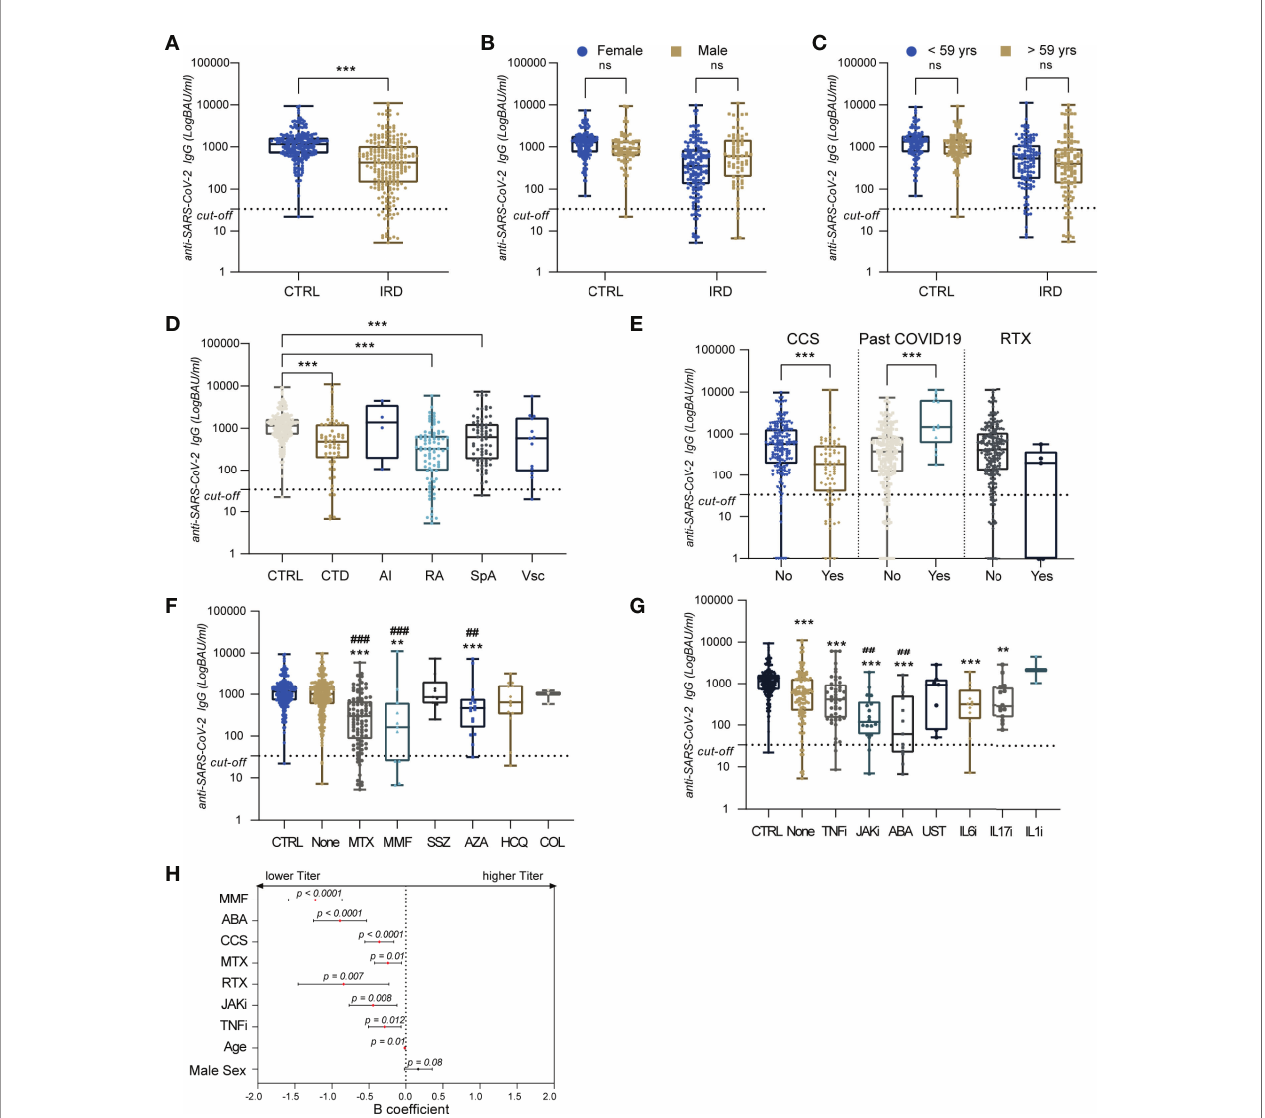
FIGURE 2 | Antibody titers after BNT162B2 vaccine in IRD and controls:Box and whiskers plot with individual data point anti-Sars-CoV-2 antibody tier expressed in BAU/mL, the box represents the IQR, line the median and hinges extend from the minimum to maximum value (A – G) . In (A) comparison of titer between control (CTRL) and patients (IRD). In (B, C) titer after strati fi cation for sex and age (> vs < the median), respectively. Levels of anti-Sars-Cov2 antibodies in the different patient ’ s groups are reported in (D) . In (E) antibody levels after strati fi cation for CCS use, past COVID19 and Rituximab treatment in the last 12 months. Antibody levels are compared across different csDMARDs (F) and bDMARDs/tsDMARDs (G) use. In (H) forest plot showing factors associated with seroconversion identi fi ed by linear stepwise regression displayed as 95% CI of B and p-value. *: statistically signi fi cant vs control population; #: statistically signi fi cant vs not taking csDMARDs or bDMARDs/tsDMARDs; **/## = p < 0.01; ***/### = p < 0.001. ns, not signi fi